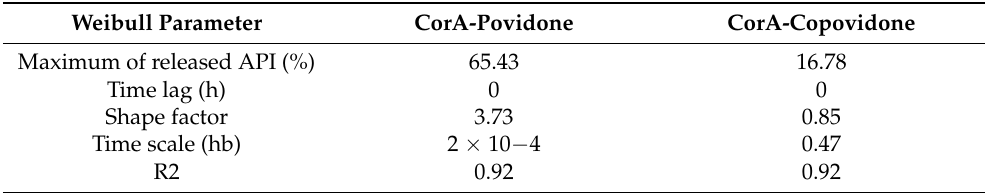
Table 4. Weibull parameters of CorA-povidone and CorA-copovidone, determined using the biorele- vant monophasic dissolution setup.